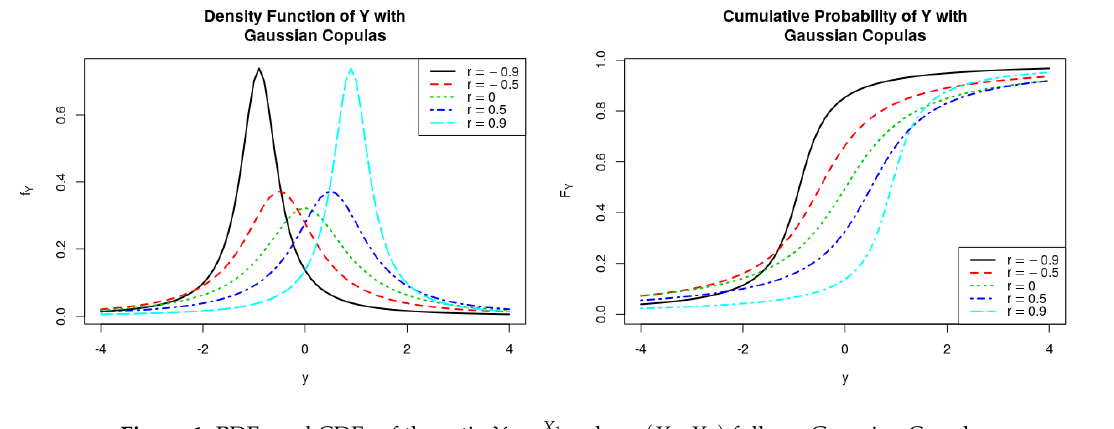
Figure 1. PDFs and CDFs of the ratio Y = X 1